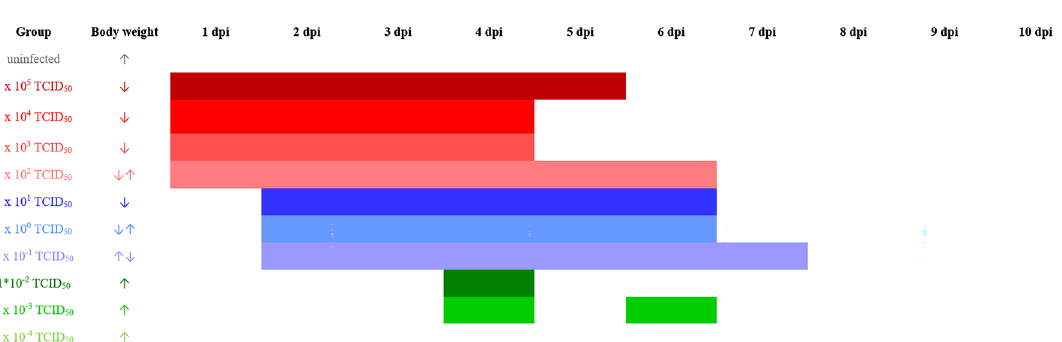
Figure 7. Time-dependent shedding of replication competent virus and change in body weight after infection with decreasing SARS-CoV-2 doses. Body weight development is shown by arrows; ↑ increasing from 1 to 7 or 10 dpi; ↓ decreasing from 1 to 7 or 10 dpi; ↓↑ decrease until 7 dpi followed by increase; ↑↓ increase until 4 dpi, followed by decrease until 10 dpi. Colors match and represent results from the same hamsters as shown before and